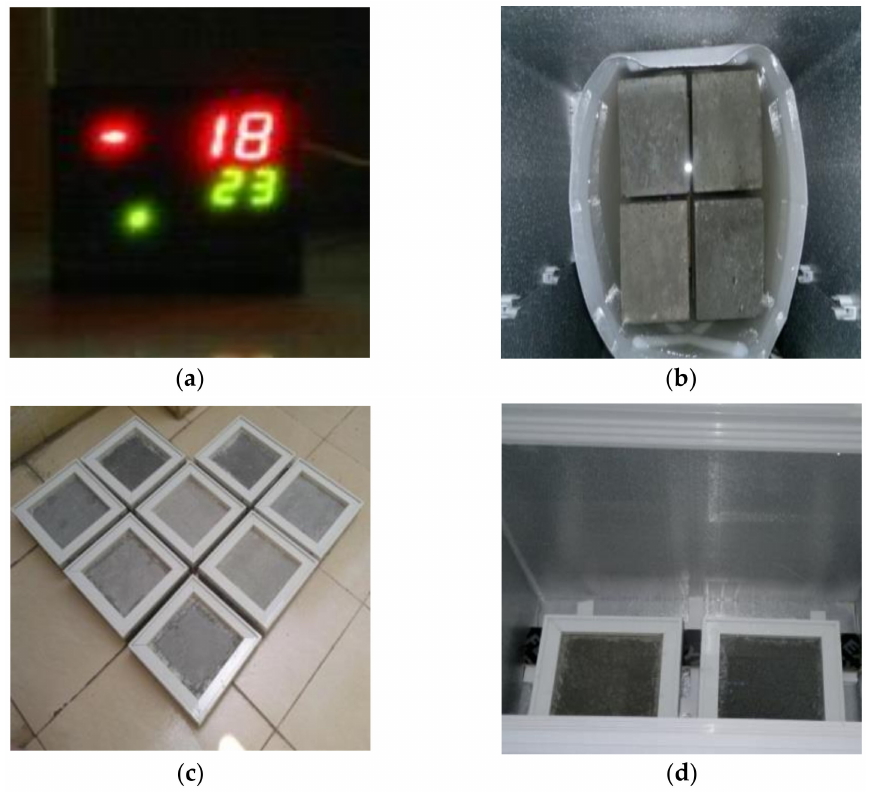
Figure 4. Freeze-thaw testing setup. ( a , b ) Freeze-thaw test for concrete cubes. ( c , d ) Scaling test for